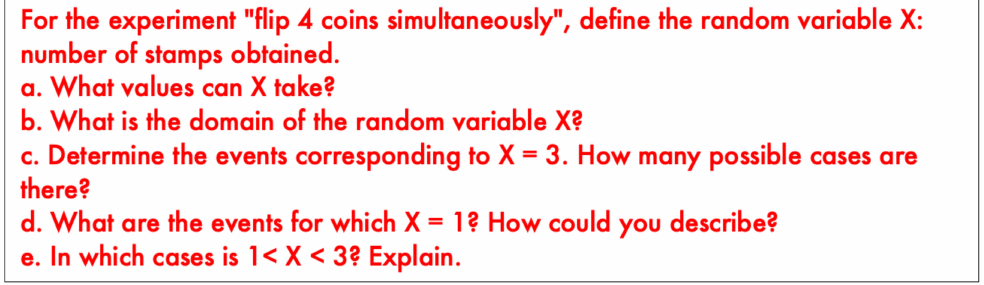
Figure 8. Example of task meaning M4 as a function (Adapted from [34] p.